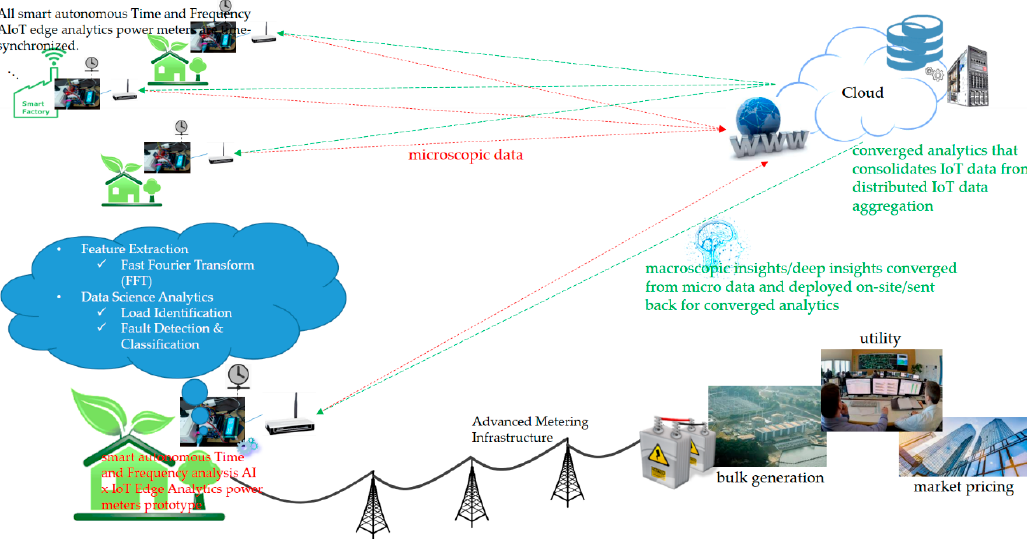
Figure 2. Conceptual vision of the smart autonomous power meter prototype considering time- and frequency-domain analysis (spectral analysis) and advanced artificial intelligence (AI) in a future smart sensing infrastructure based on fog-cloud analytics for demand-side management (DSM) in a smart grid.